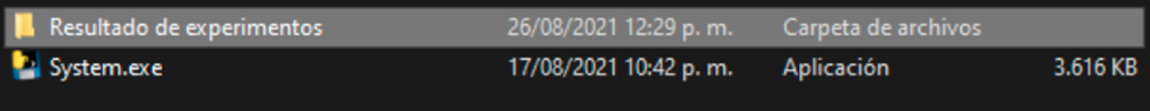
Figure 9. File with the partial times recorded.